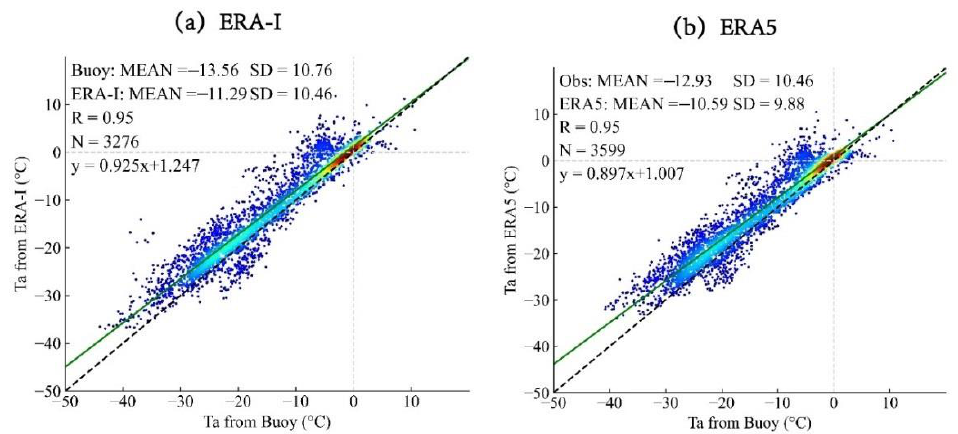
Figure 3. Scatter plot of the daily mean Ta from the ( a ) ERA-I and ( b ) ERA5. The black dashed line indicates the 1:1 line, and the green line indicates the fitting curve equation of all of the matching pairs.